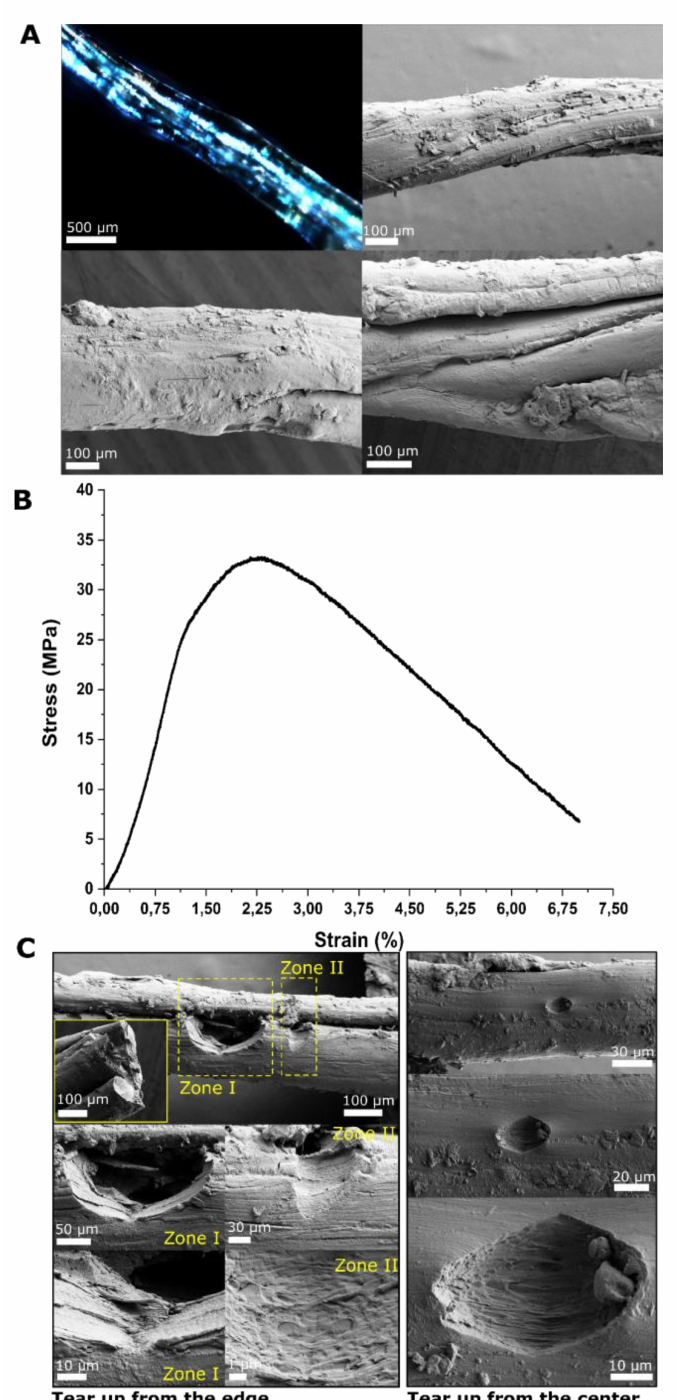
Figure 4. Rolling the skin into fiber-shaped material and testing its mechanical properties. ( A ) Po- larized microscopy of a fiber-like material made from the skin. The panel also shows SEM images from three different regions of the same fiber which demonstrates inhomogeneity in the thickness and surface morphology throughout the length of the fiber. ( B ) Representative stress–strength curve for the corresponding sample as in ( A ). ( C ) SEM images of the material after the tensile measurement test illustrating typical tears observed throughout the length of the